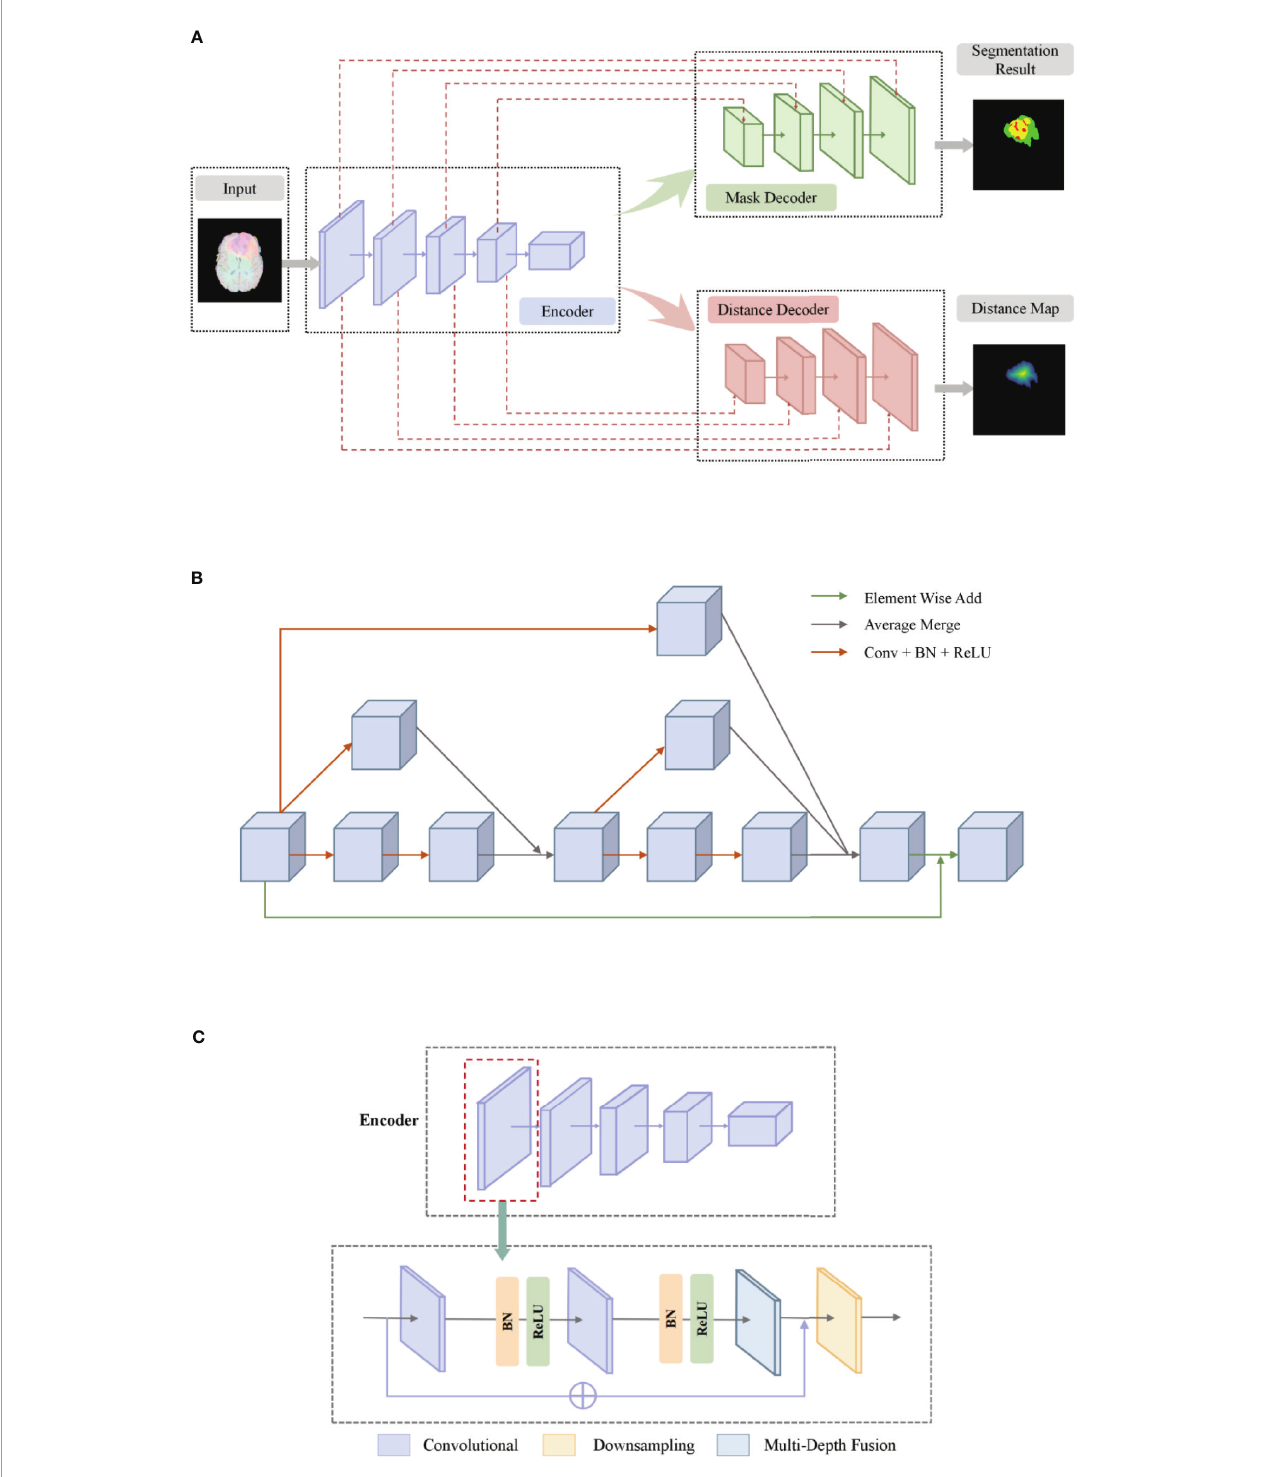
FIGURE 2 | (A) The network structure of our deep multi-task learning framework. (B) Structure diagram of the multi-depth fusion module. (C) A detailed illustration of the